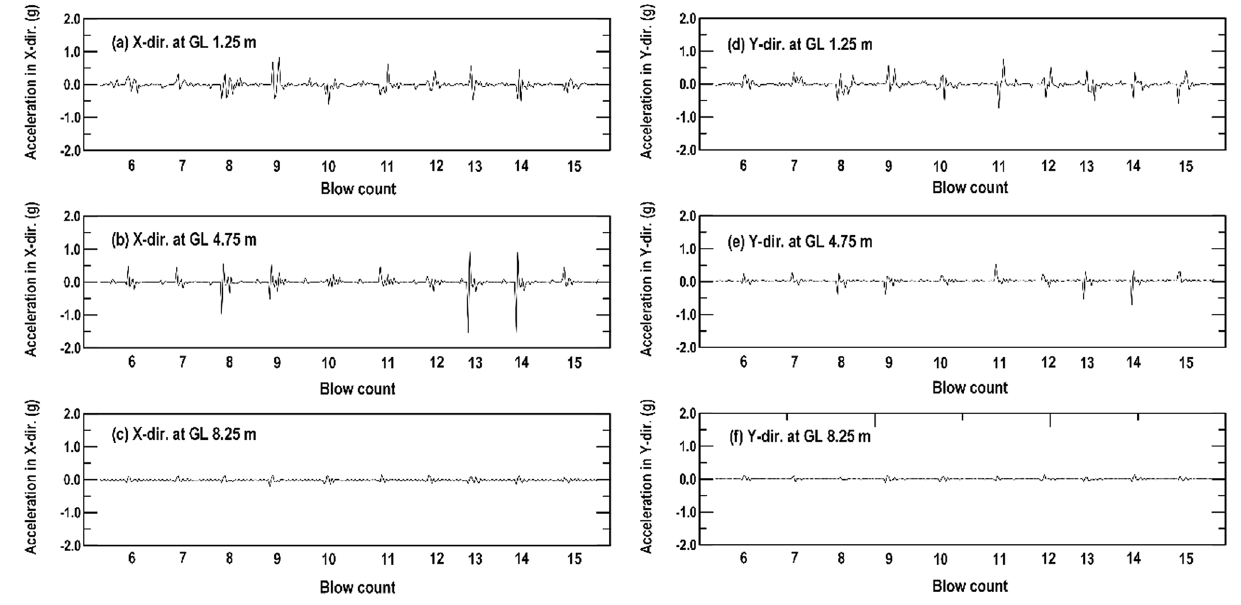
Figure 8. Acceleration record for the selected window in Fig. 7 (impact from 6 to 15 blows): ( a – c ) X-direction response at GL values of 1.25, 4.75, and 8.25 m; ( d – f ) Y-direction response at GL values of 1.25, 4.75, and 8.25 m (GL, ground